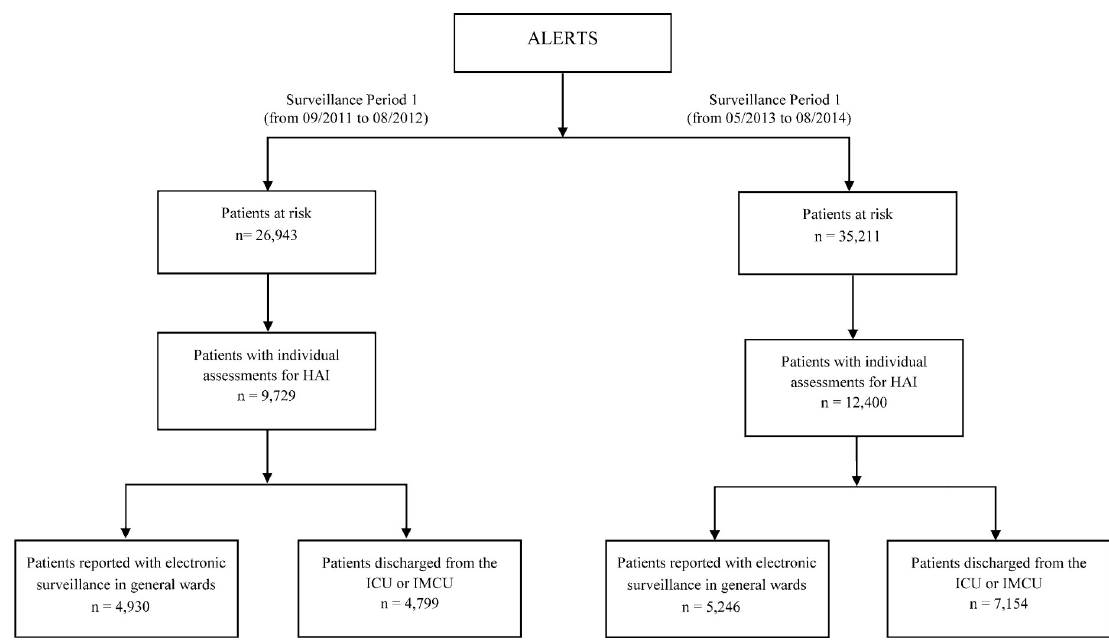
Fig 2. Flow chart of surveillance of healthcare-associated infections (HAIs) in ALERTS study.